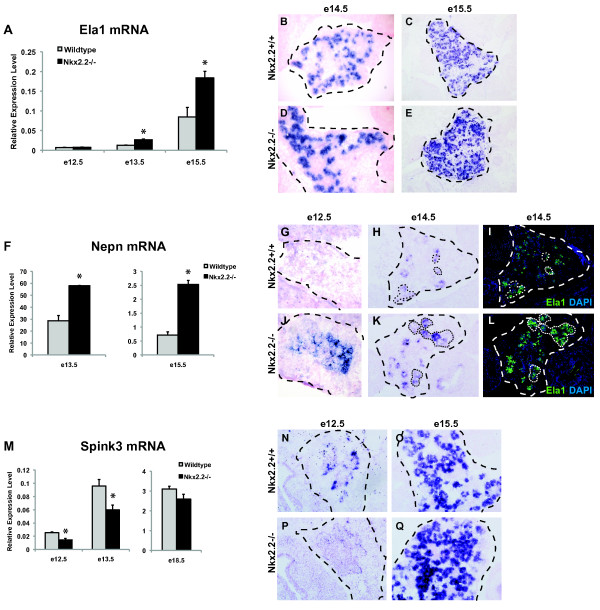
Loss of Nkx2.2 affects expression of known exocrine factors, Ela1, Spink3, and a novel secreted proteoglycan, Nepn. qRTPCR of (A) Ela1 mRNA was assessed at e12.5, e13.5, and e15.5, (F) Nepn mRNA was assessed at e13.5 and e15.5, and (M) Spink3 mRNA transcript levels were determined at e12.5 and e13.5, while all gene expression analyses compared wild type (grey bars) and Nkx2.2-/- pancreata (black bars). In situ hybridization comparing wild type and Nkx2.2-/- pancreas at e14.5 and e15.5 for Ela1 (B, C, D, and E), e12.5 and e14.5 for Nepn (G, H, J, and K), e12.5 and e15.5 for Spink3 (N, O, P, and Q). To show co-expression of Nepn in the exocrine compartment and confirm increased protein levels, Ela1 immunofluorescence was performed on adjacent sections (I and L;green). DAPI (C and E; blue) indicates nuclei. Error bars represent SEM and asterisks denote statistical significance < 0.05. Magnification 20×. Large dashed lines outline the pancreas at e12.5, e14.5, and e15.5. Small dashed lines outline areas of Nepn and Ela1 co-expression.